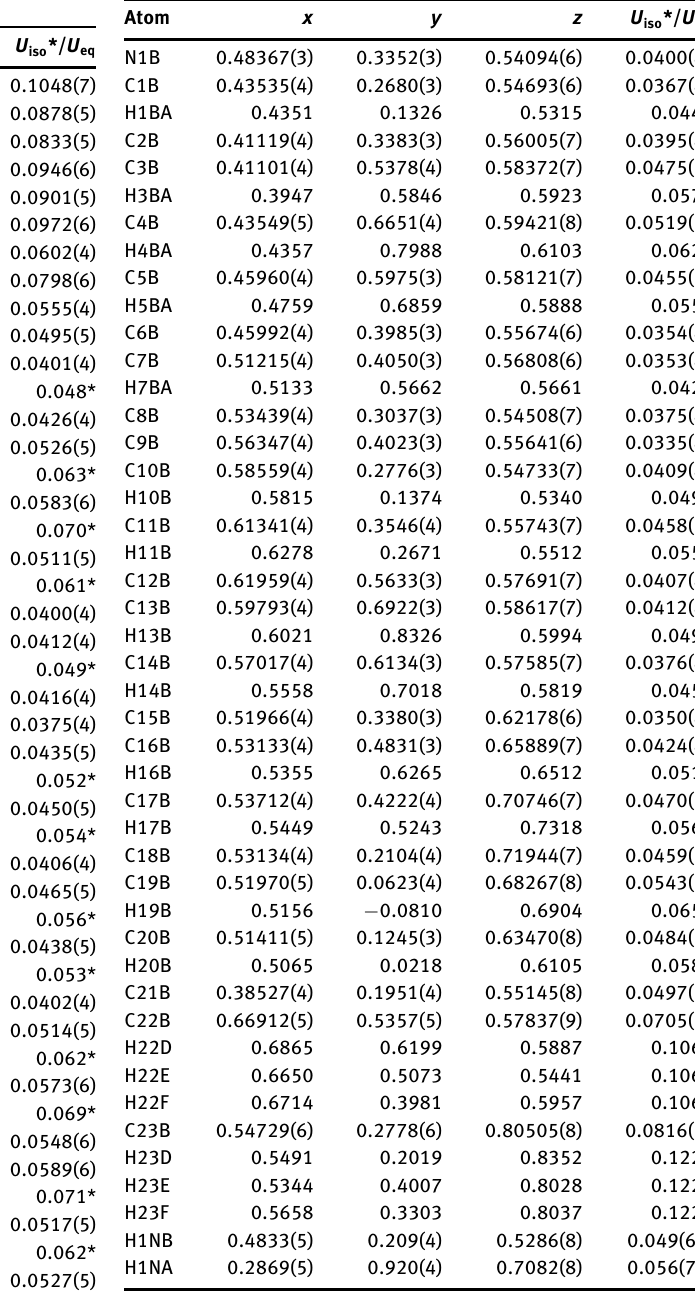
Table 2: Fractional atomic coordinates and isotropic or equivalent isotropic displacement parameters (Å 2